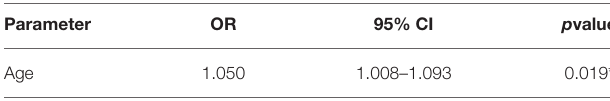
TABLE 4 | Independent risk factor correlated with a higher incidence of intracranial aneurysm in patients with acoustic neuroma. Parameter OR 95% CI p value Age 1.050 0.019* OR, odds ratio; CI, confidence